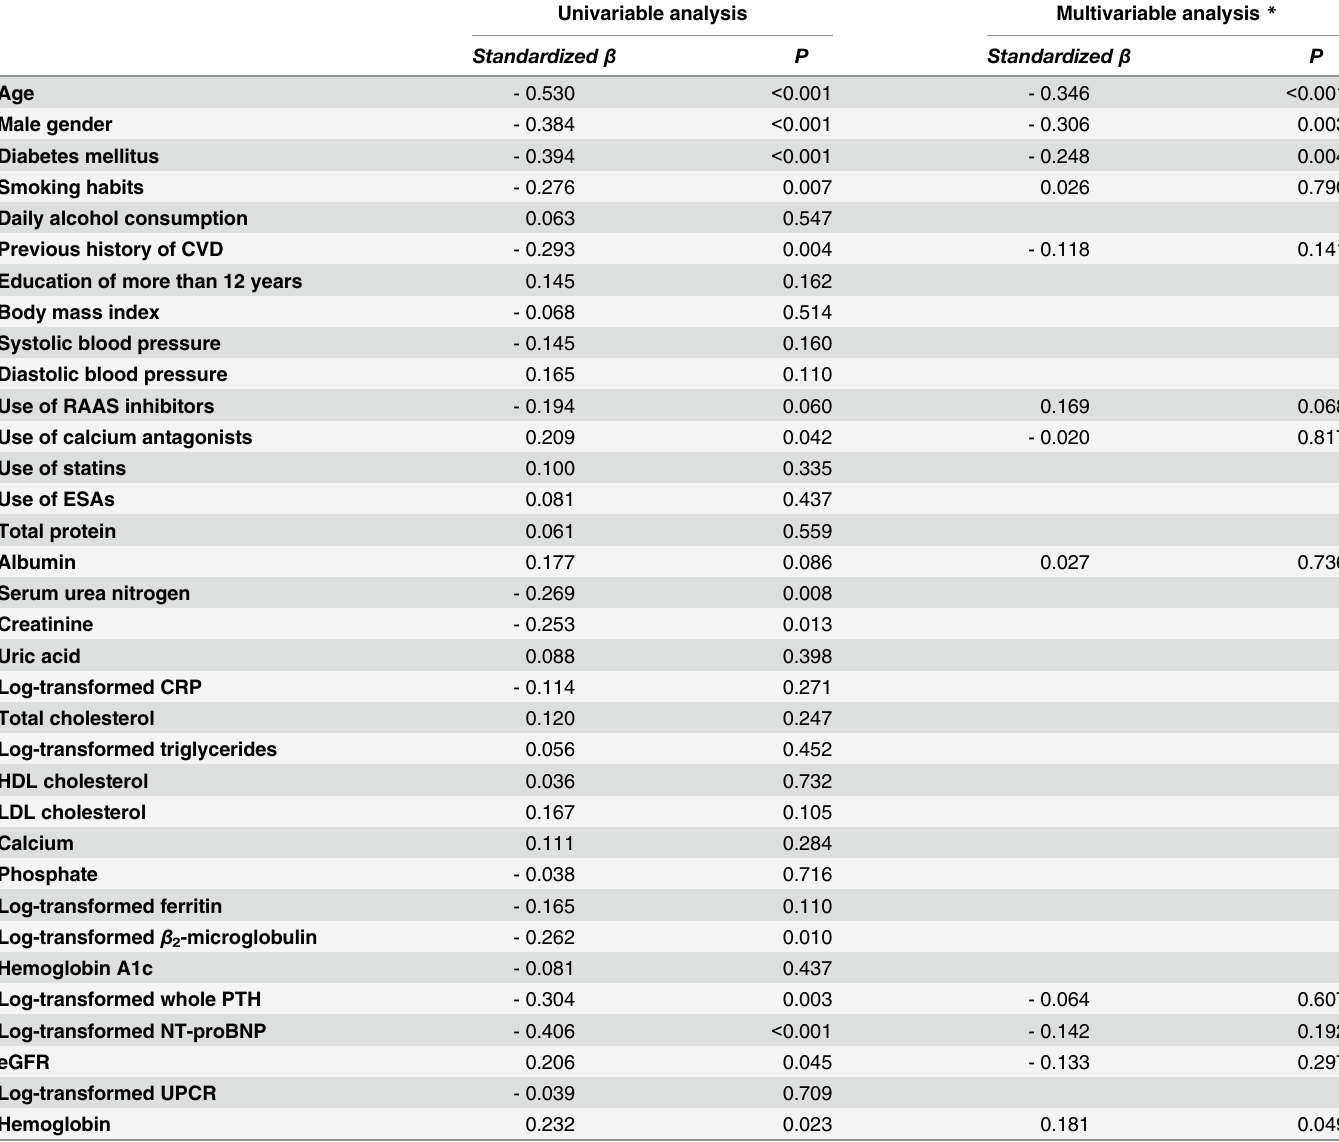
Table 7. Univariable and Multivariable-Adjusted Regression Analyses for Normalized GMV. Abbreviations: CRP, C-reactive protein; CVD, cardiovas- cular disease; eGFR, estimated glomerular filtration rate; ESA, erythropoiesis-stimulating agent; GMV, gray matter volume; HDL, high-density lipoprotein; LDL, low-density lipoprotein; NT-proBNP, N-terminal pro-brain natriuretic peptide; PTH, parathyroid hormone; RAAS, renin-angiotensin-aldosterone system; UPCR, urinary protein to creatinine